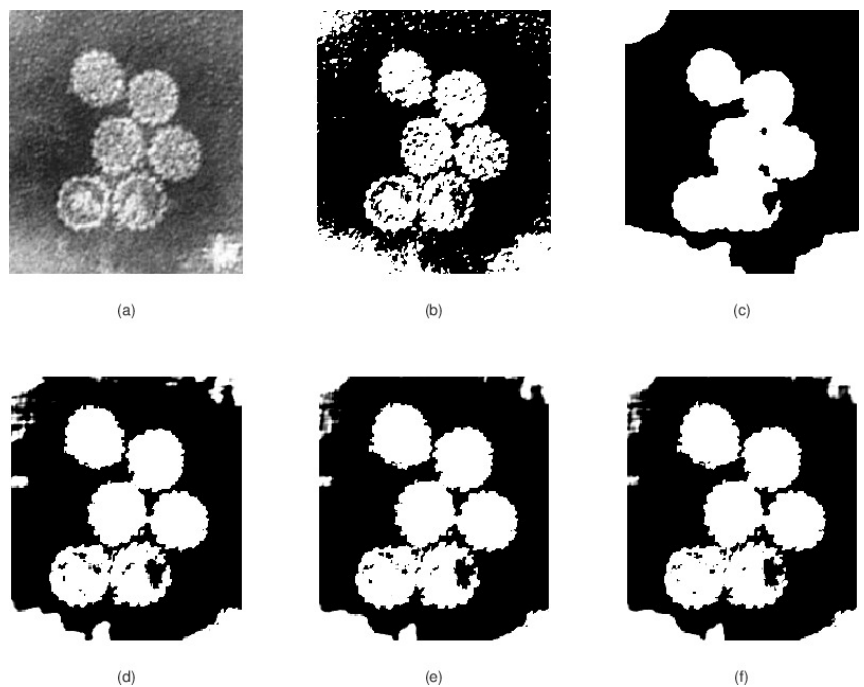
Figure 4. ( a ) Original input image to be segmented; ( b ) K-means segmentation results; ( c ) Chan–Vese segmentation results; ( d–f ) Our model segmentation results after 1–3 iterations.